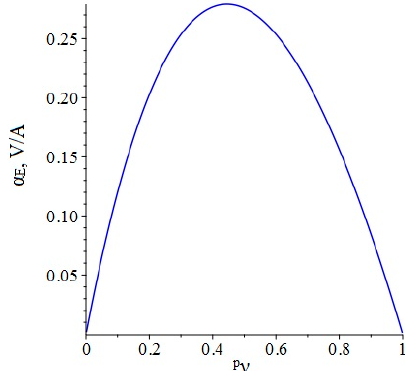
Figure 11. Theoretical dependence of the ME voltage coefficient on the volume fraction of the piezoelectric material for ME structure Metglas/GaAs of the longitudinal-shear mode.